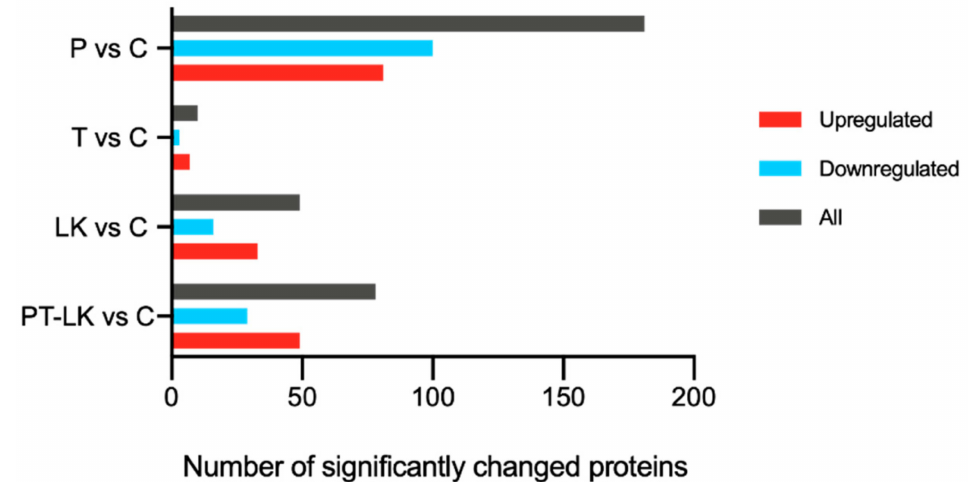
Figure 6. Proteomic changes in B. subtilis spores in response to different